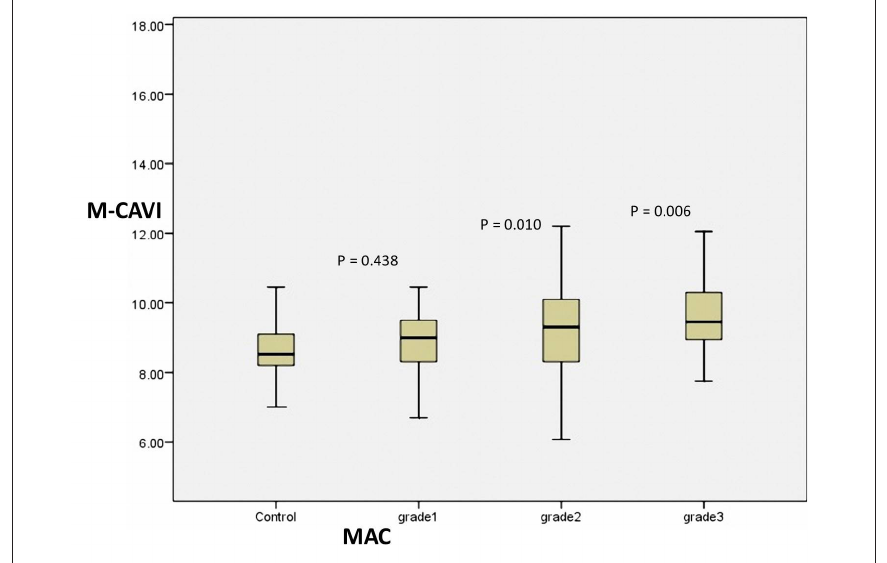
Figure 2. Box plot showing M-CAVI values of the control group and grade of MAC-positive groups. M-CAVI, mean cardio-ankle vascular index; MAC, mitral annular calcification.